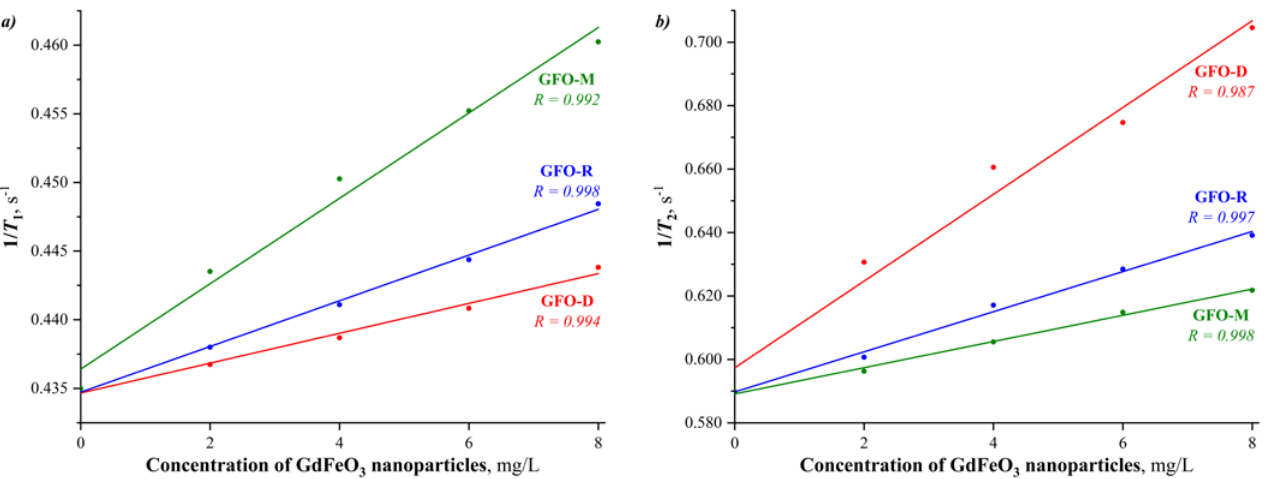
Figure 9. MR relaxivity curves of the colloidal solutions of GdFeO 3 nanoparticles obtained using direct (GFO-D), reverse (GFO-R) and microreactor (GFO-M) co-precipitation techniques: longitudinal ( a ) and transverse ( b ).